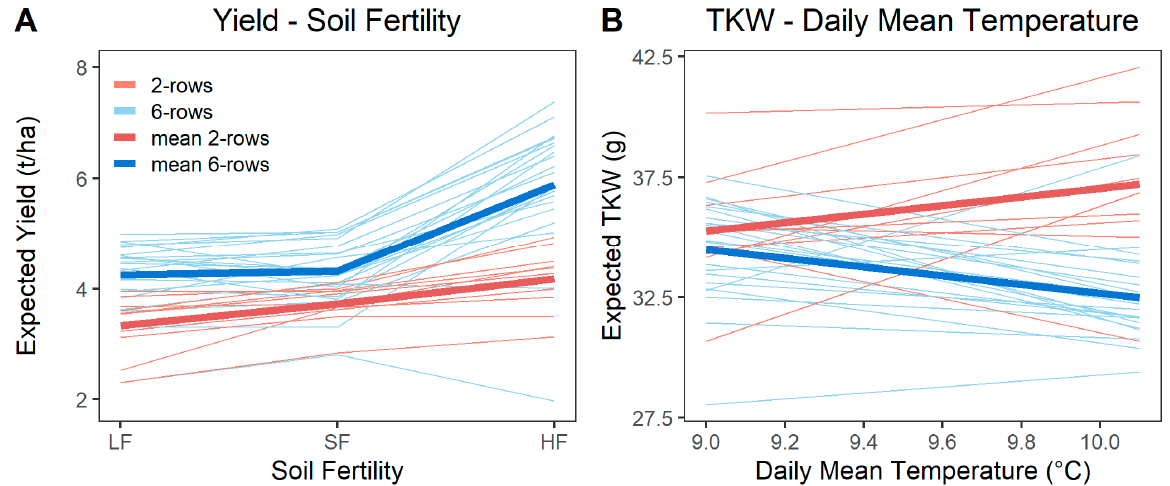
Figure 3. Expected phenotypic response of ( A ) yield and ( B ) thousand kernel weight (TKW) according to the tested environmental factor: soil fertility for yield and daily mean temperature for thousand kernel weight. Genotypes were colored according to their type: 6r in blue and 2r in red. Bolded lines represent the mean expected phenotypic response for each group.